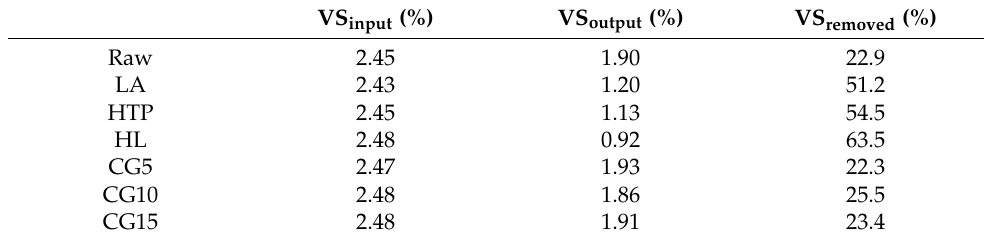
Table 5. VS input , VS output , and VS removed values of all experimental groups.